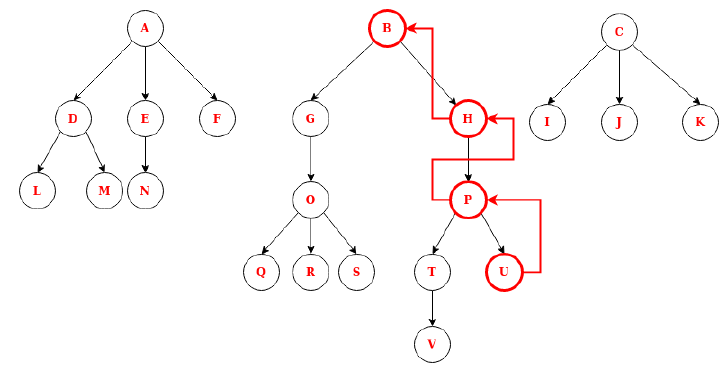
Figure 5. Finding